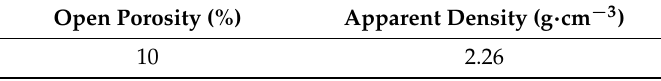
Table 4. Results of sandstone open porosity and its bulk density.